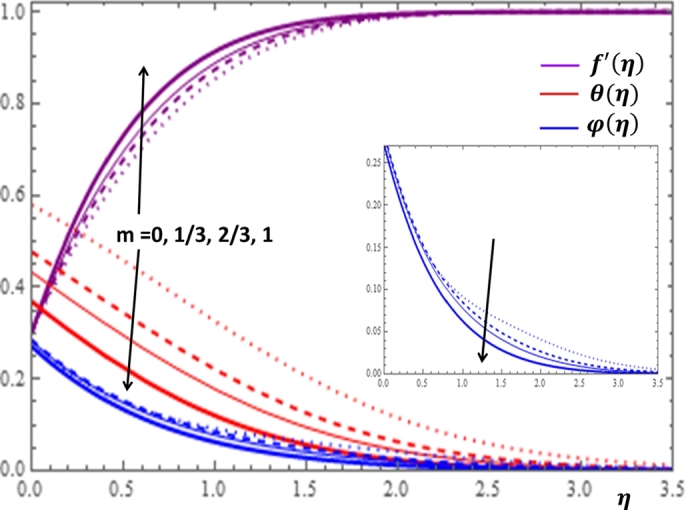
Impacts of the wedge angle parameter m on f′(η), θ(η) and φ(η).